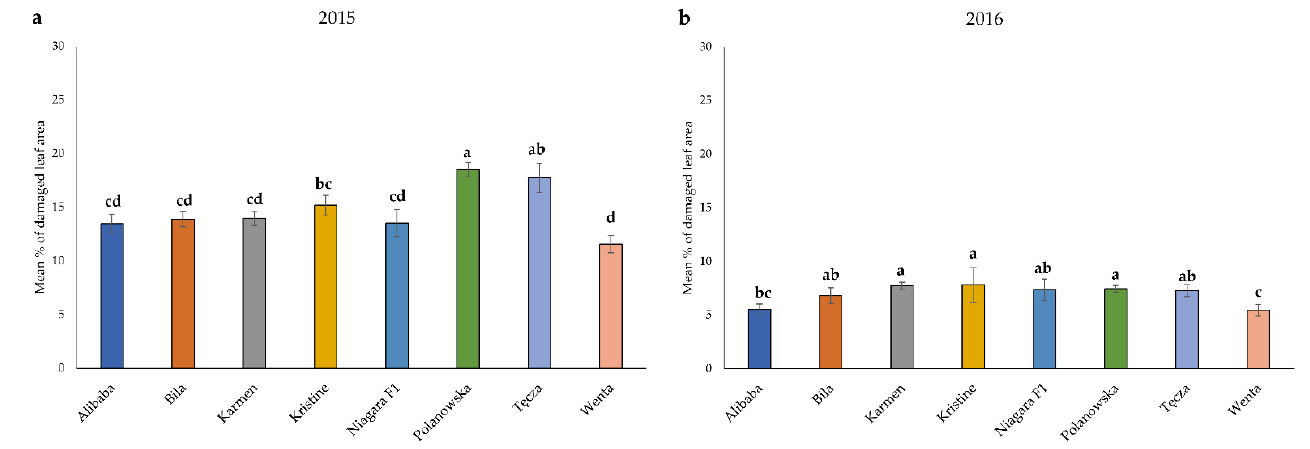
Figure 2. Mean ( ± SE) percentage of the damaged leaf area caused by feeding thrips throughout the all growing season ( a ) in 2015 and ( b ) in 2016. Means with the same letters on each bar are do not differ significantly different (Duncan’s multiple range Test, p < 0.05).